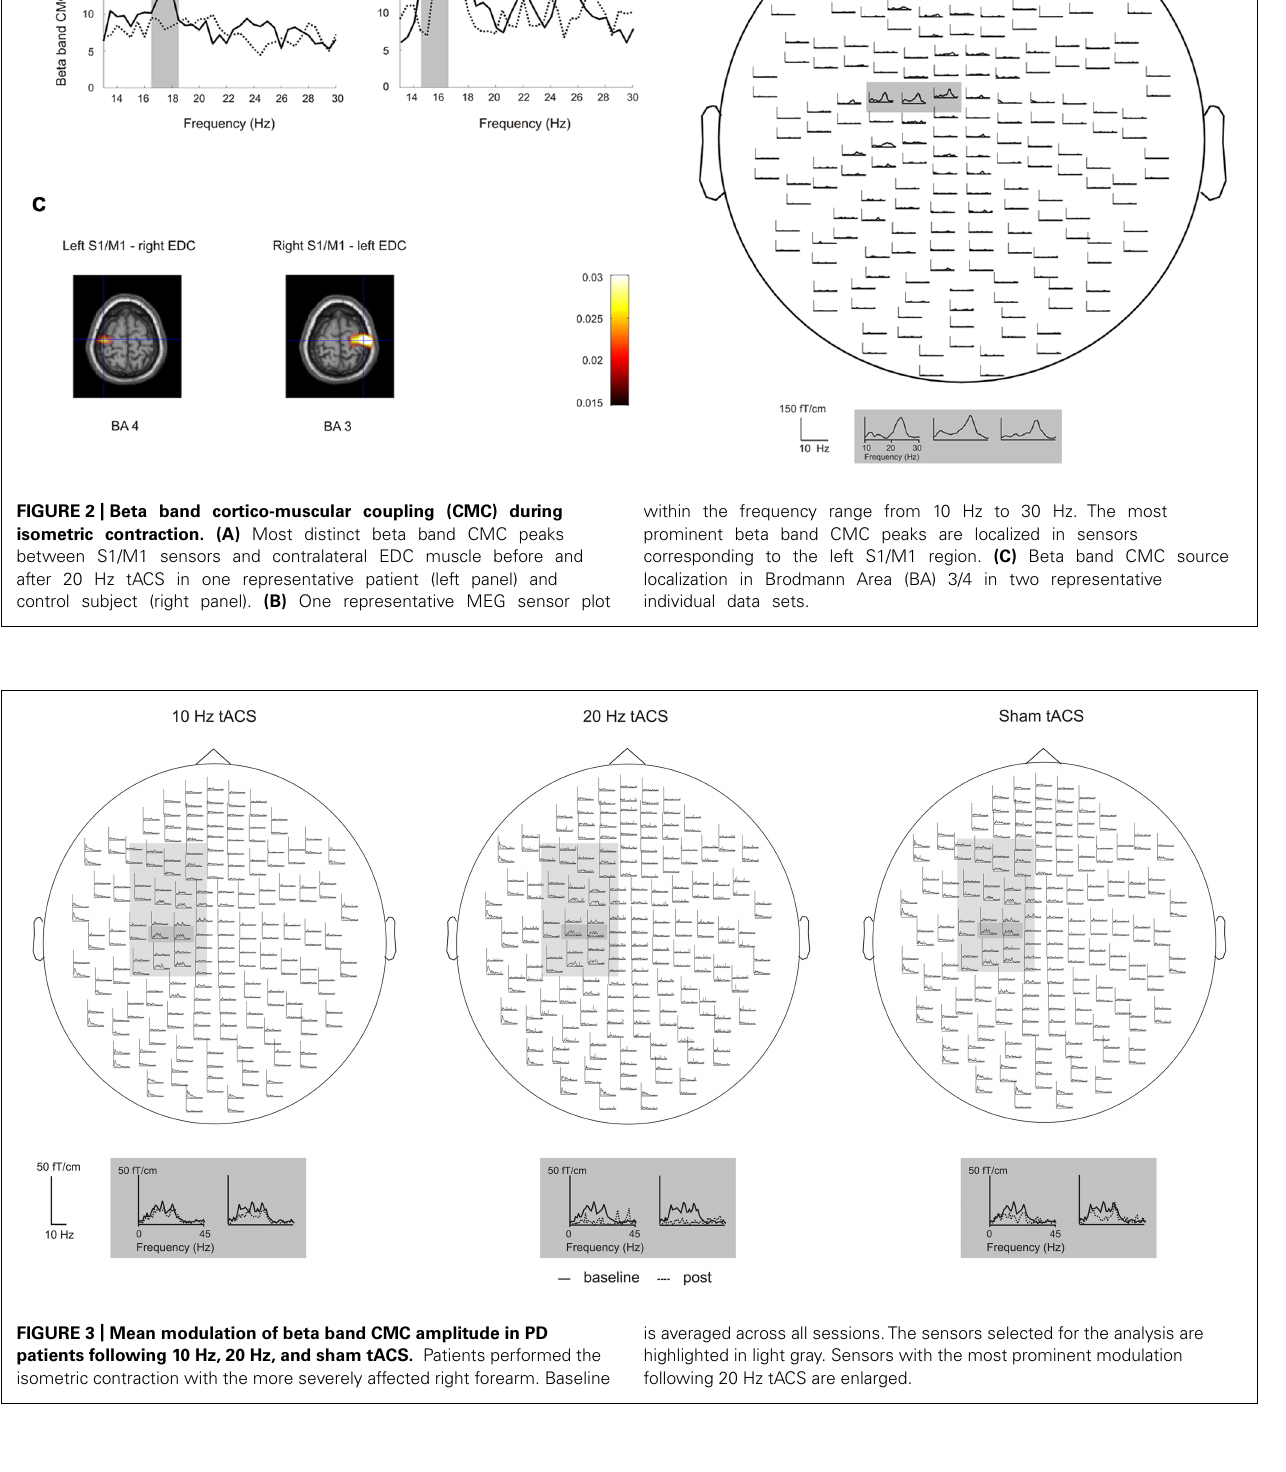
is averaged across all sessions.The sensors selected for the analysis are highlighted in light gray. Sensors with the most prominent modulation following 20 Hz tACS are